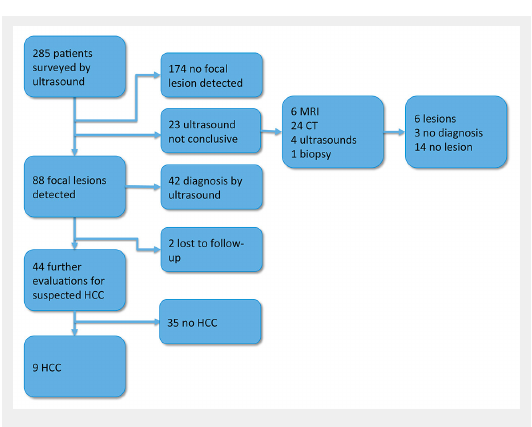
Diagnostic work-up and results in the 285 patients surveyed at the University Hospital Basel in the years 2011 and 2012. CT = computed tomography; HCC = hepatocellular cancer; MRI = magnetic resonance imaging resonance